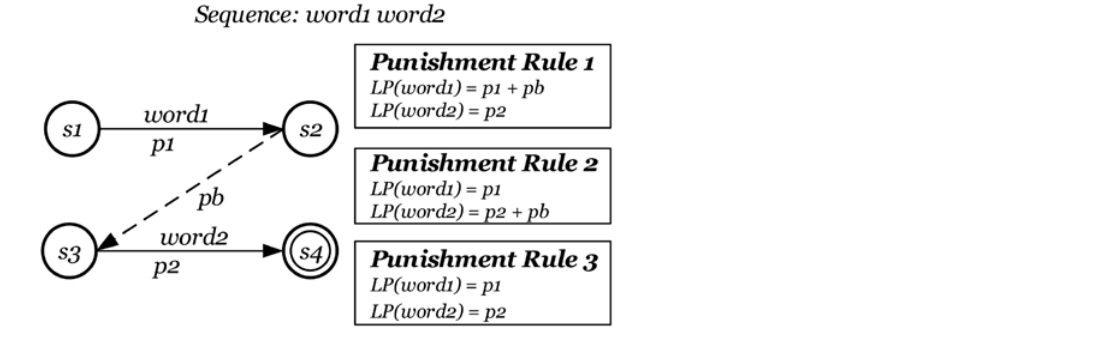
Figure 7: Three Punishment